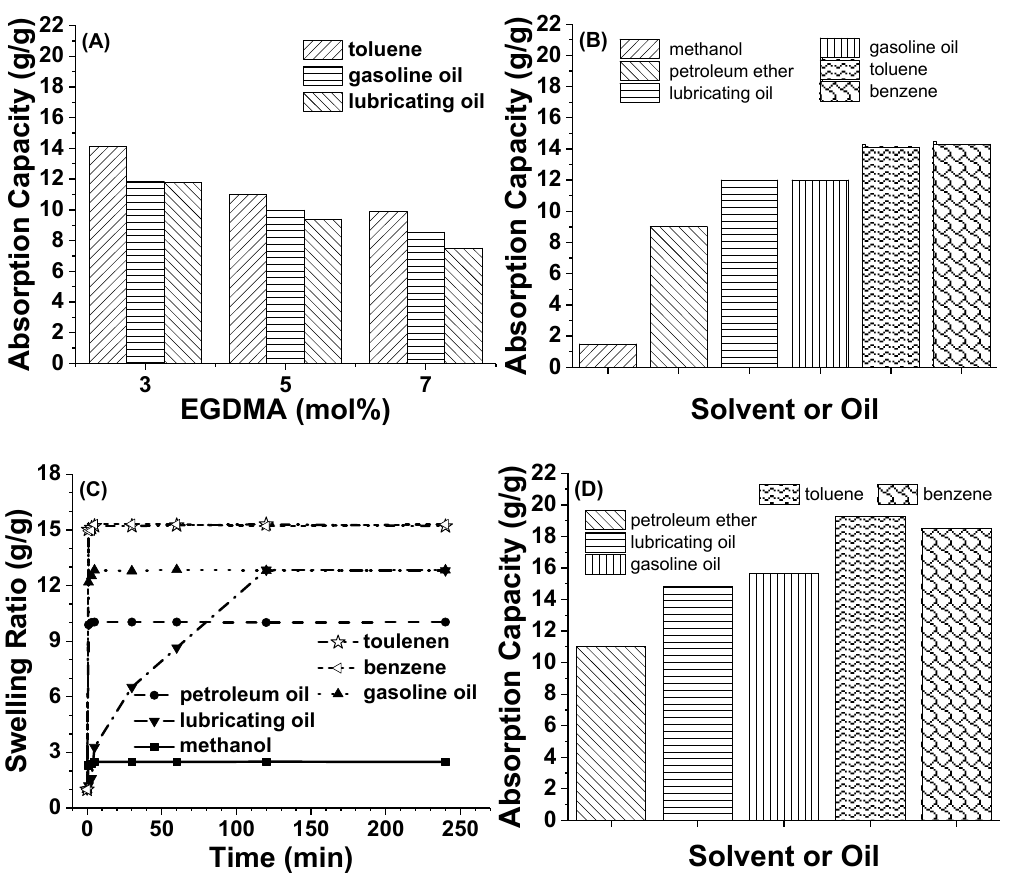
Figure 4. ( A ) Influence of crosslinking degree on the absorption capacity of cryogels prepared at 2 °C and [M] 0 = 0.6 mol/L; ( B ) Dependence of absorption capacity for the C-63p2 cryogel on solvent/oil; ( C ) Absorption kinetic of the C-63p2 cryogel; ( D ) Absorption capacity of the C-63p4 cryogel prepared at 4 °C and [M] 0 = 0.6 mol/L.